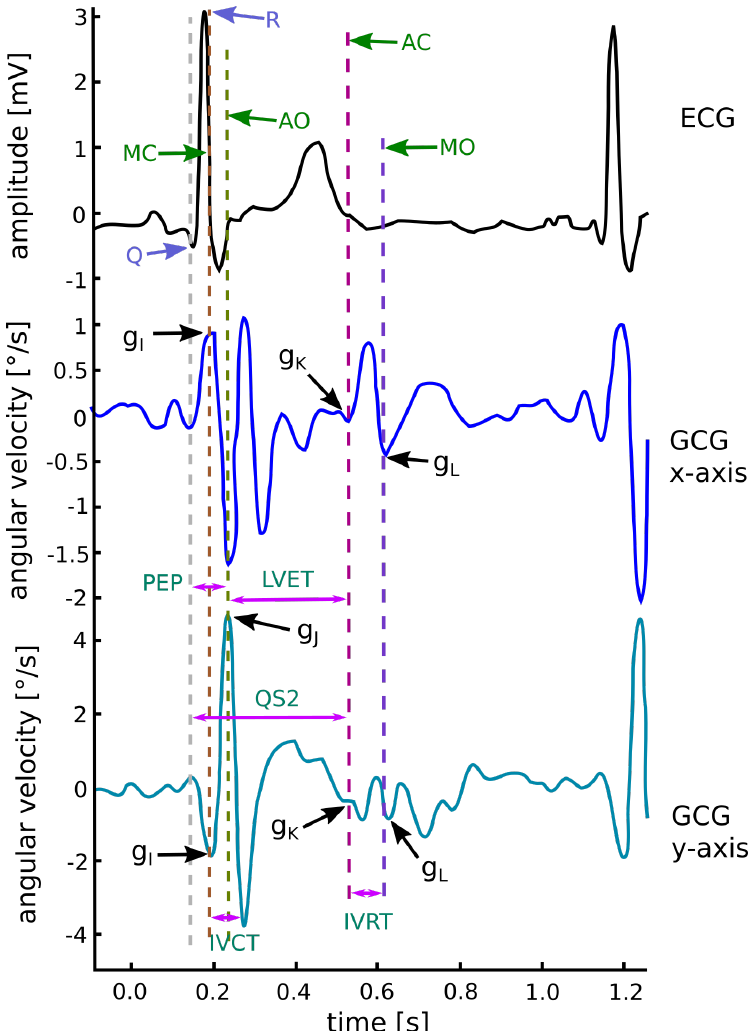
Figure 9. Waveform annotation in GCG x- and y-axis with corresponding time intervals and reference ECG. Modified version of the diagram by Tadi et al. published in [11] under the CC-BY 4.0